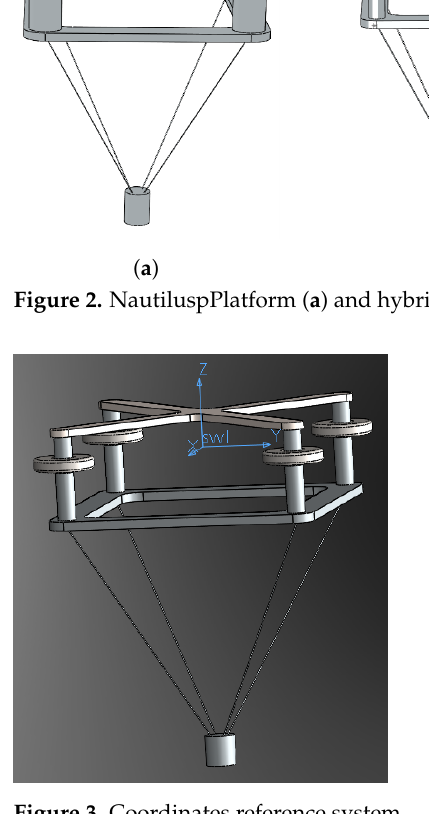
Figure 3. Coordinates reference